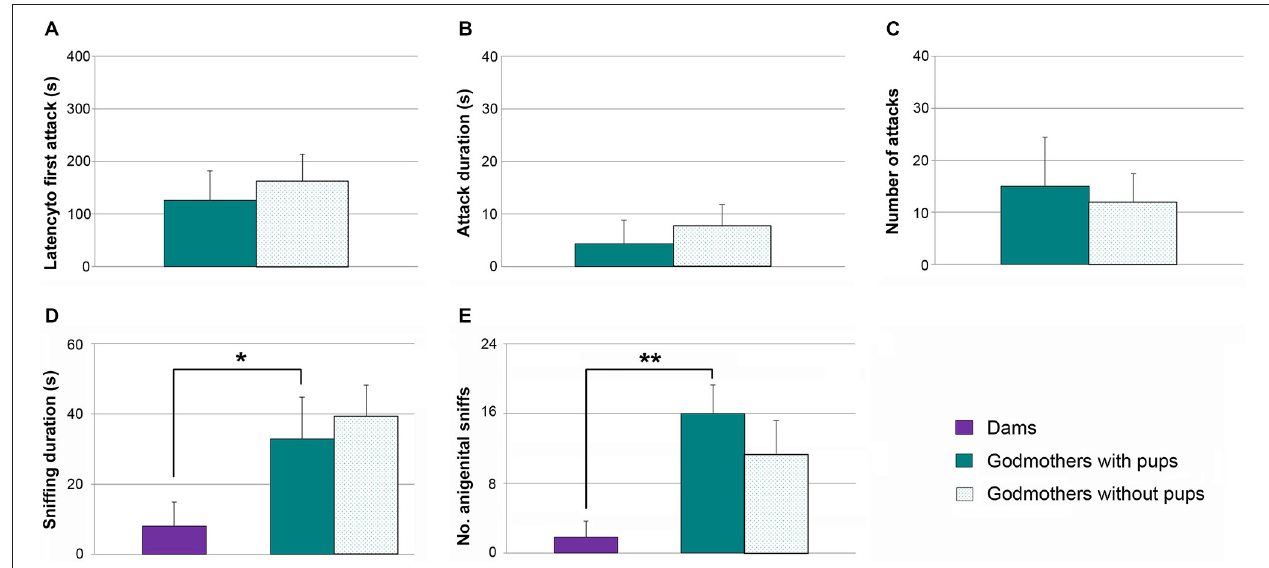
FIGURE 5 | Godmothers are not aggressive irrespective of the presence of pups, and display more socio-sexual investigation of